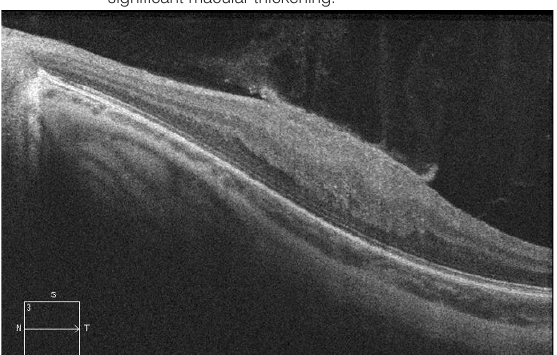
Figure 2. Optical coherence tomography of the epiretinal mem- brane in the left eye, showing atypical, curled edges with significant macular